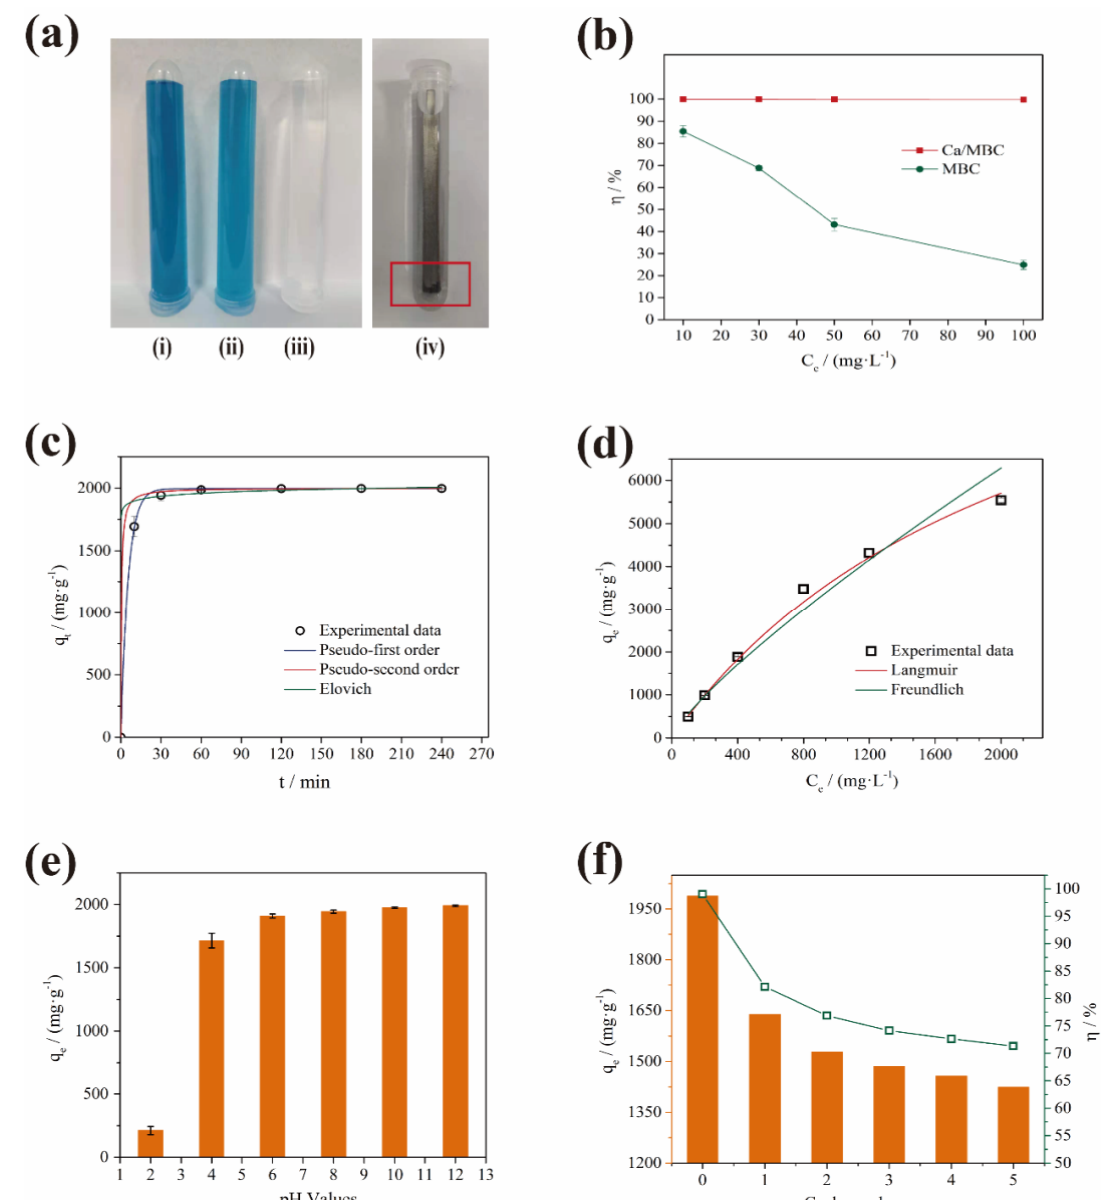
Figure 5. ( a ) Effect of MBC and Ca/MBC adsorption and magnetic recovery on MG: (i) 50 mg/L MG; (ii) 50 mg/L MG + MBC; (iii) 50 mg/L MG + Ca/MBC; (iv) 50 mg/L MG + MBC + magnet rod; ( b ) Comparison of MBC and Ca/MBC sorption rates on MG; ( c ) Isothermal adsorption fitting curve; ( d ) Adsorption kinetic fitting curve; ( e ) Effect of initial pH on MG adsorption by Ca/MBC; ( f ) Effect of Ca/MBC adsorption on MG after 5 times adsorption-desorption.